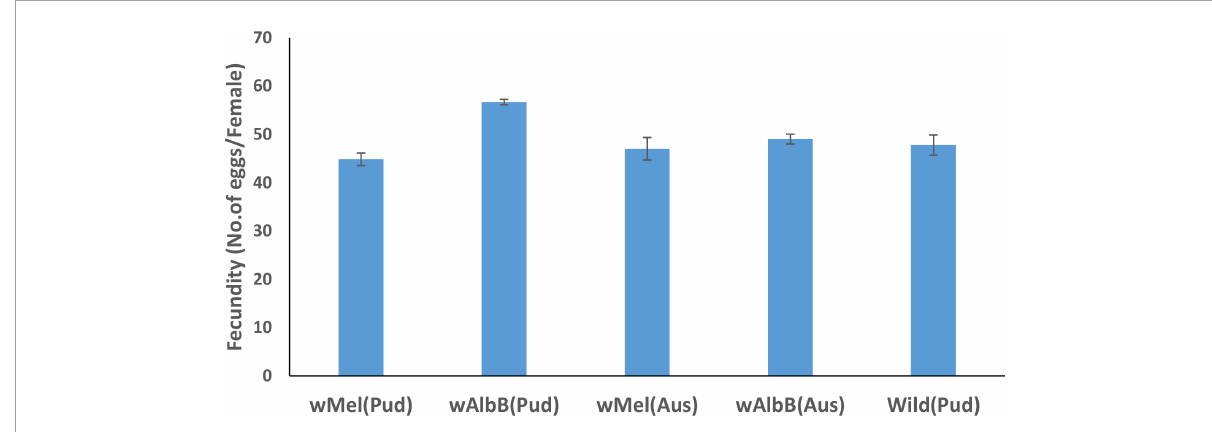
FIGURE1 Fecundity (average number of eggs per female ± SE) of Wolbachia -infected Ae. aegypti females and uninfected wild Ae. aegypti (Pud) females.